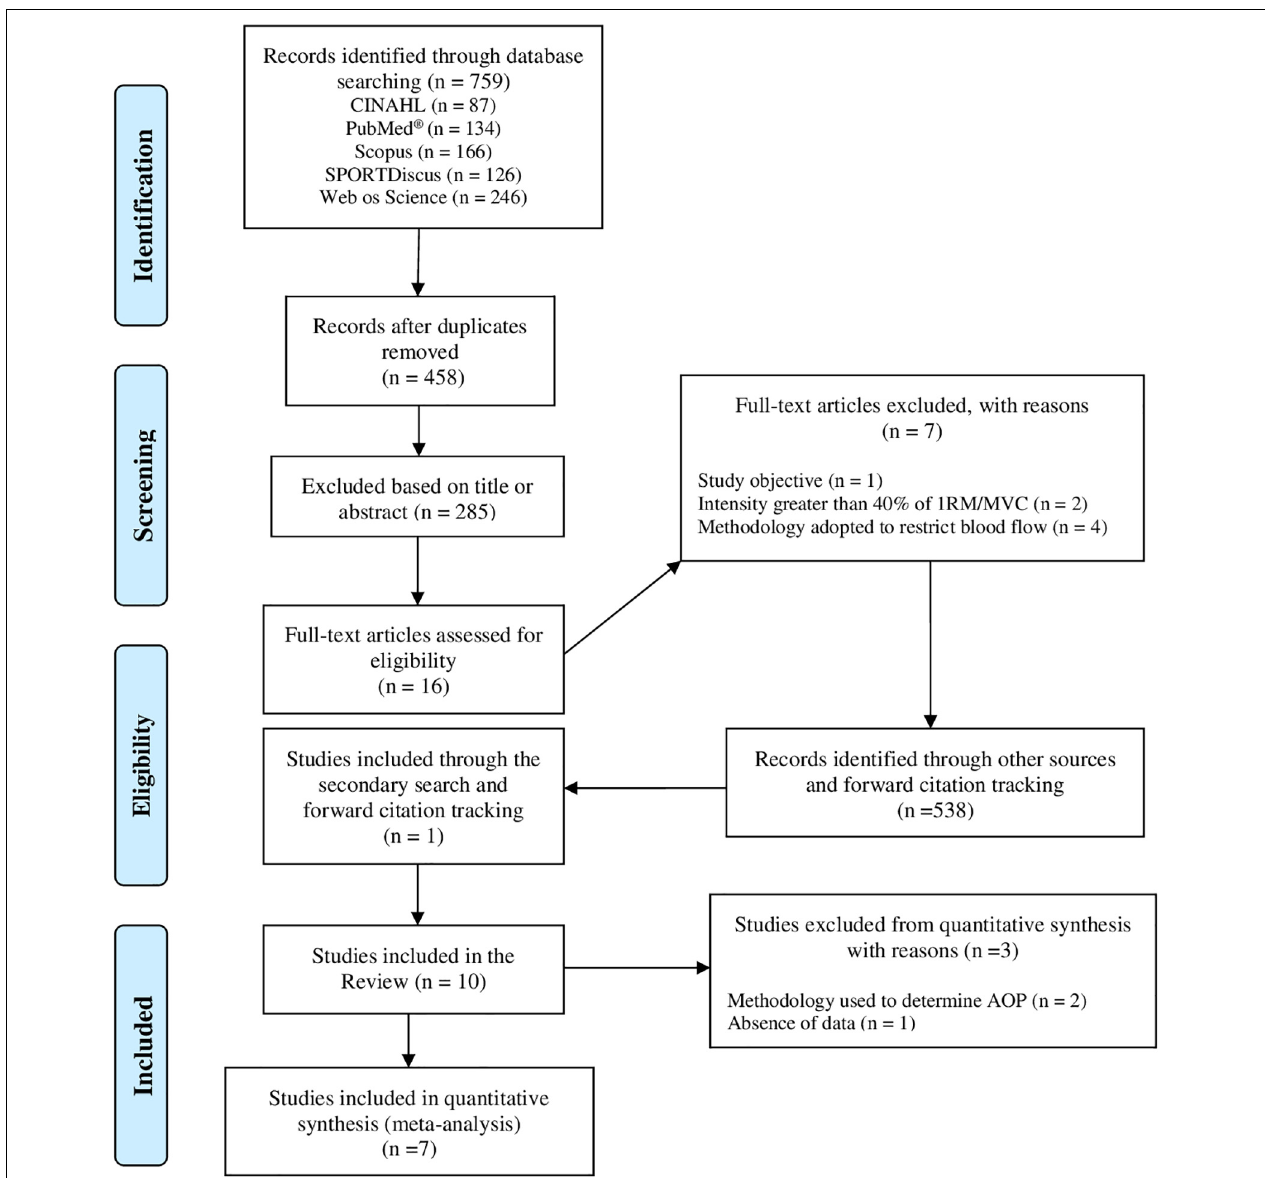
FIGURE 1 | PRISMA flow diagram of study